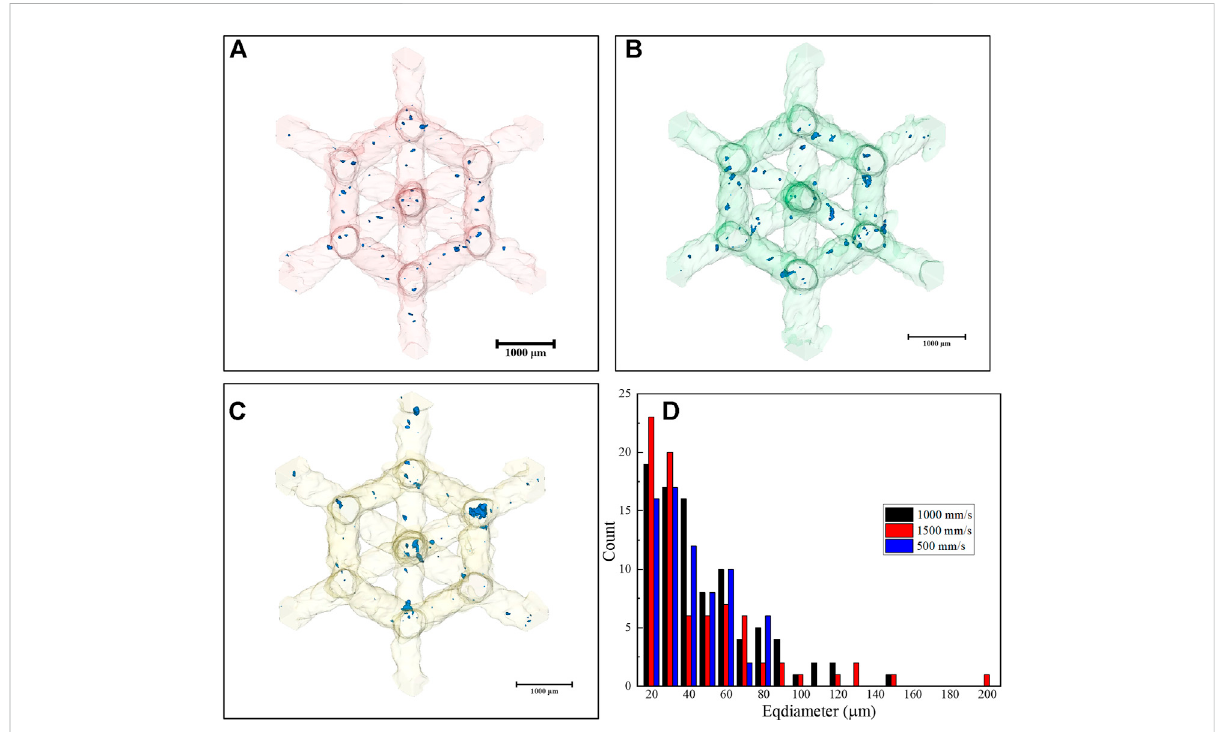
FIGURE 4 Morphology of the inner defects in the materials built at 500 mm/s (A) , 1000 mm/s (B) , 1500 mm/s (C) , and size and distribution of the inner defects in the materials fabricated with different laser scanning speeds (D)